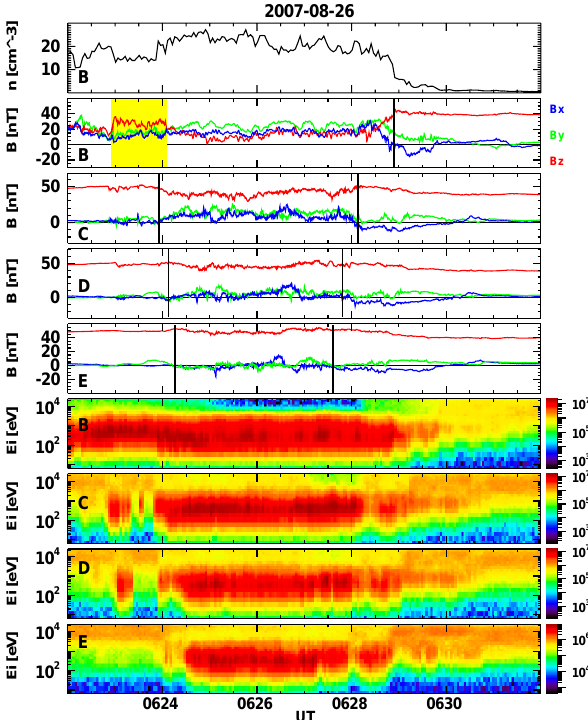
Fig. 9. Overview of the event 2. A detailed view of the density, magnetic fields and ion spectra. The short vertical lines indicate approximate times of sharp changes of the density of low-energy ion population. The yellow area marks an interval of the change of discussed B Z magnetosheath magnetic field